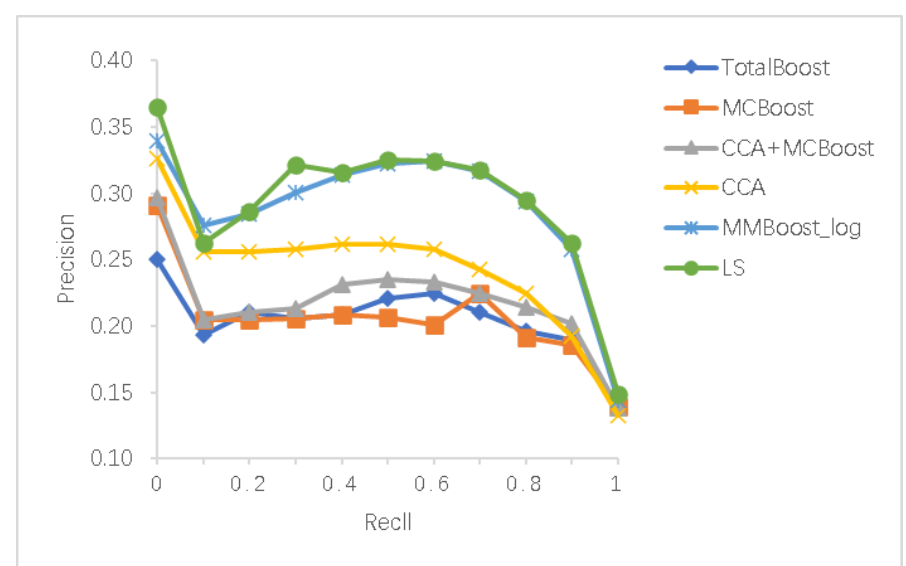
Figure 6. Precision–recall curves for image retrieval